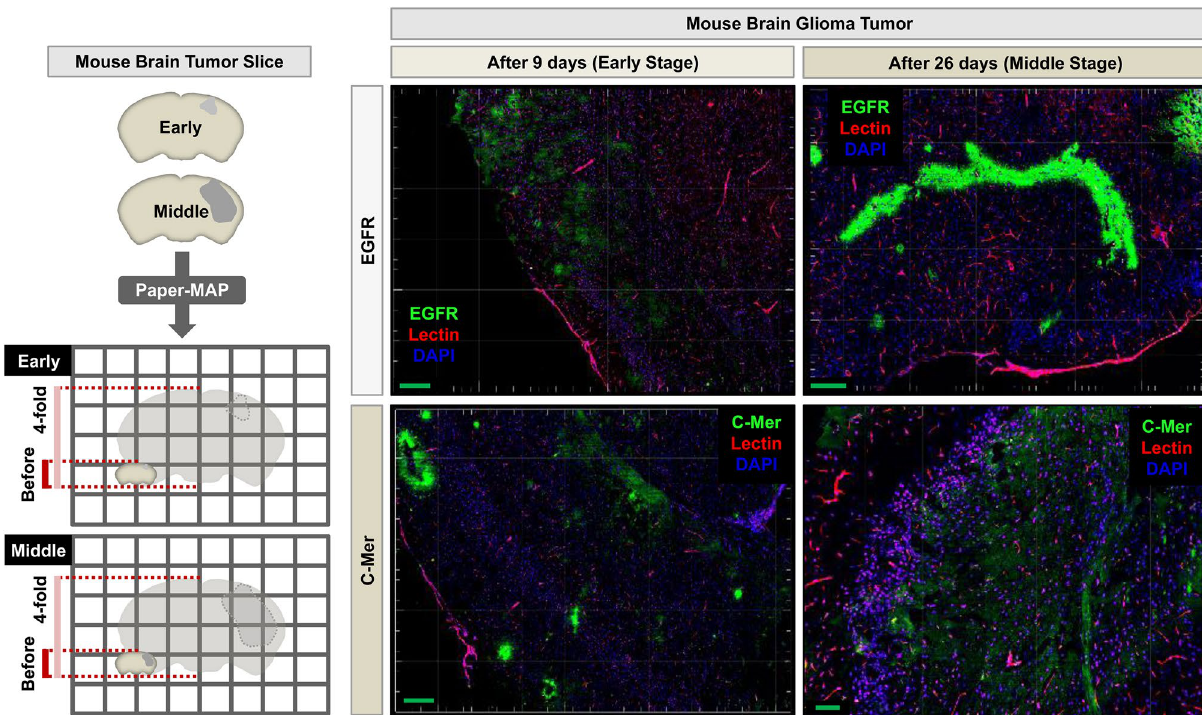
Figure 7. Application of Paper-MAP for tissue clearing and expansion in mouse brain tumor. Schematic representation of Paper-MAP processing using 100 μm-thick mouse brain tumor sections. Paper-MAP processing of human glioma xenografts upon 9 and 26 days post-transplantation in mice, followed by immunostaining for EGFR (green), c-Mer (green) and lectin (red). Scale bars: green = 2000-μm. Illustration of mechanism is visualized by PowerPoint